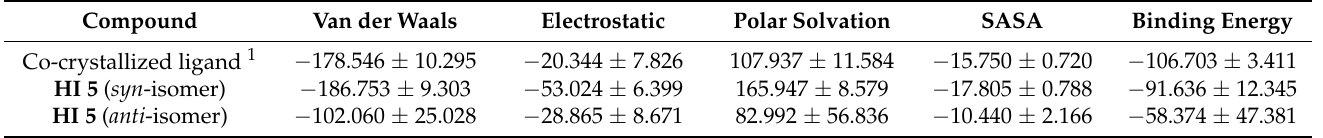
Table 6. HI 5 syn / anti -isomers and co-crystallized ligand energies (kJ/mol).